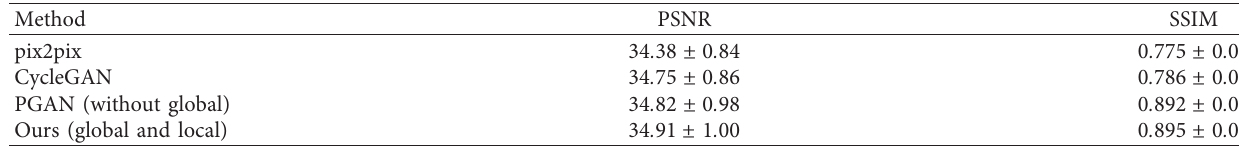
Table 1: Comparisons of T2-weight MRI synthesis between our proposed method with different approaches of PSNR and SSIM (data in the table denote the average value and standard deviation of the test dataset).